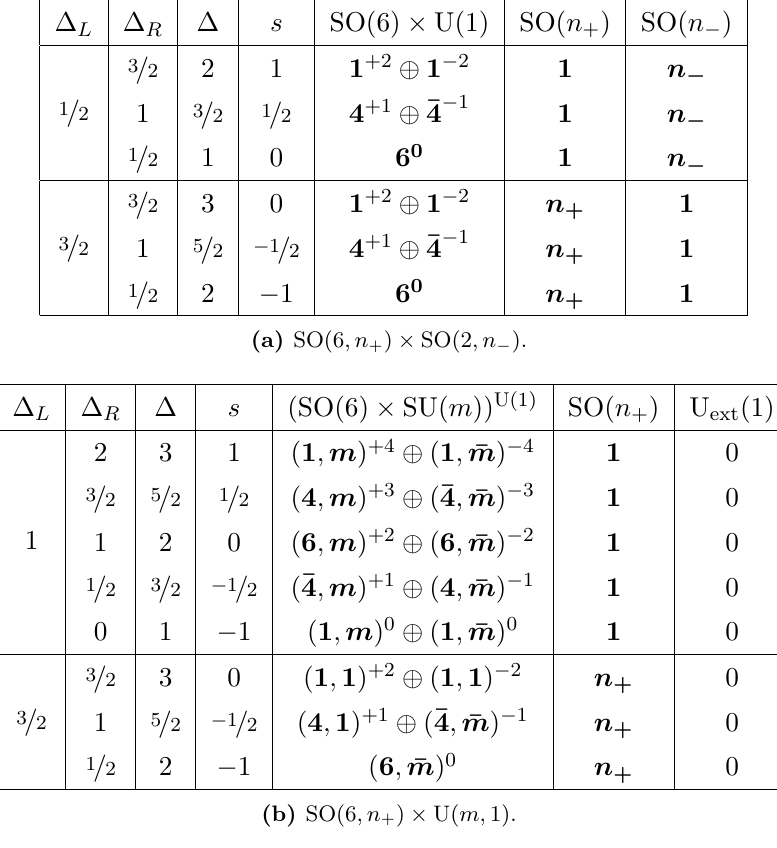
Table 13. Mass spectra for SU(4 1 ; 1) solutions for chiral embedding (2.21b) with (a) (cid:18) j and (b) (cid:18) = 0. These are the multiplets of SU( 1 ; 1) given in table 1 of ref. [23] for m = n j MNPQ 6 which implies once again that the only non-vanishing components of (cid:18) pqrs are (cid:18) p The other equations are then equivalent to the following set of independent